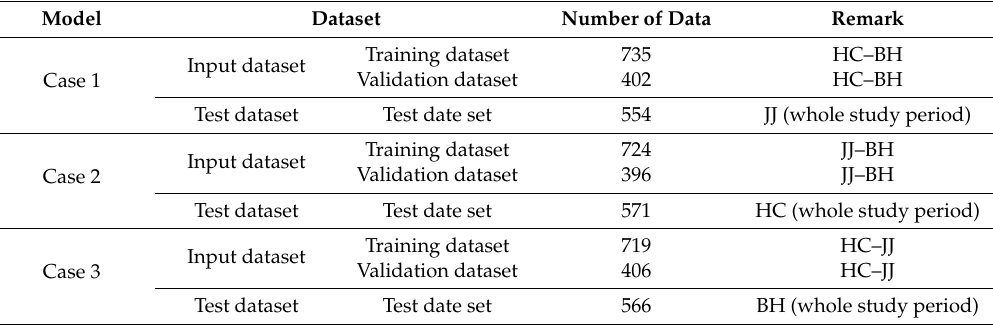
Table 4. Dataset for CNN model.